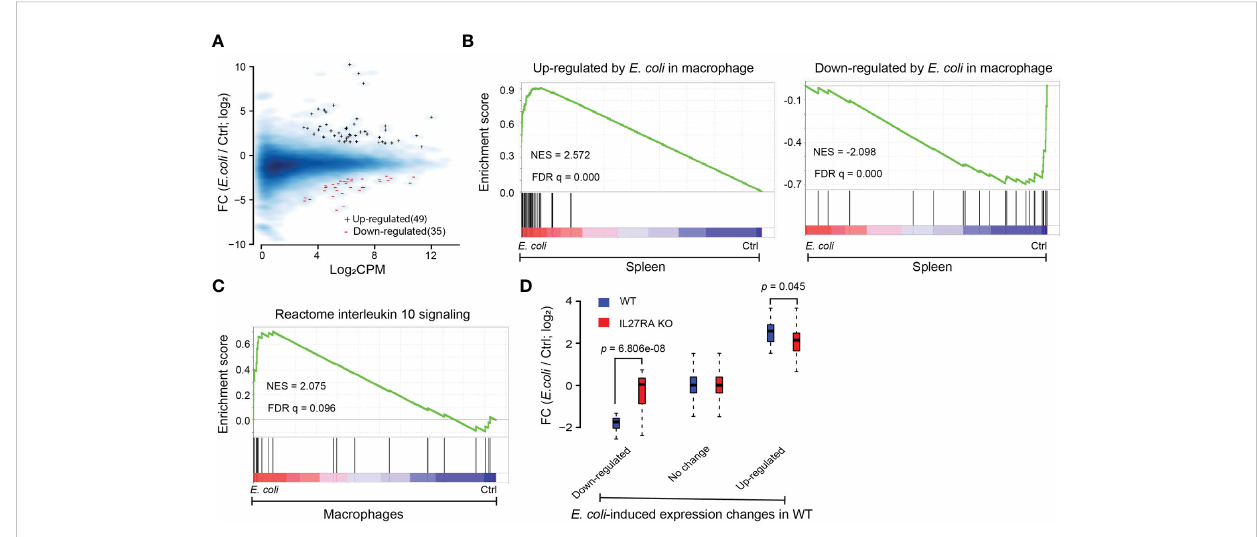
FIGURE 5 Compromised transcriptional response to E. coli in macrophage-enriched cells de fi cient in IL-27R a . (A) MA plot for genes differentially expressed between E. coli -treated and non-treated (Ctrl) WT macrophages. Blue +: genes upregulated after E. coli infection; red -: genes down-regulated after E. coli infection; Blue smooth heat map: all expressed genes; FC, Fold change; CPM, Counts per million reads. (B) GSEA analysis for expressed genes ranked by fold change of expression ( E. coli /Ctrl in WT spleen) from high to low on the red-to-blue spectrum against genes upregulated (vertical bars on the left panel) or downregulated (vertical bars on the right panel) by E. coli in WT macrophages. NES: normalized enrichment score. (C) GSEA analysis for expressed genes ranked by the fold change of expression ( E. coli /Ctrl in WT macrophages) from high to low on the red-to-blue spectrum against genes from Reactome IL10 signaling pathway (vertical bars). (D) Boxplots of expression changes induced by E. coli in macrophages de fi cient in IL-27R a (KO; red boxplots) and in WT macrophages (blue boxplots) for genes sorted based on their expression response to E. coli in WT macrophages. Down-regulated: genes down-regulated by E. coli as compared to nontreatment (Ctrl) in WT macrophages; up-regulated: genes up- regulated; No change: genes with no signi fi cant expression changes; P -value by paired t -test. FC, Fold